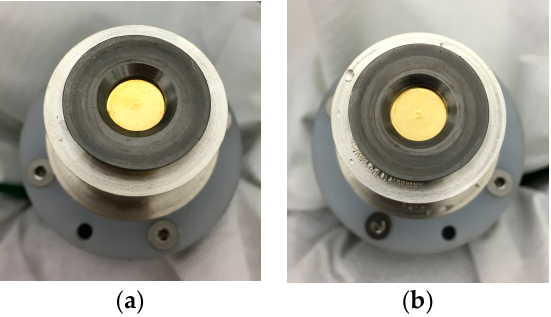
Figure 6. ( a ) Au foil before irradiation on the 3D-printed SS925 solid target holder. ( b ) Au foil after being subjected to experimental protocol as described above.